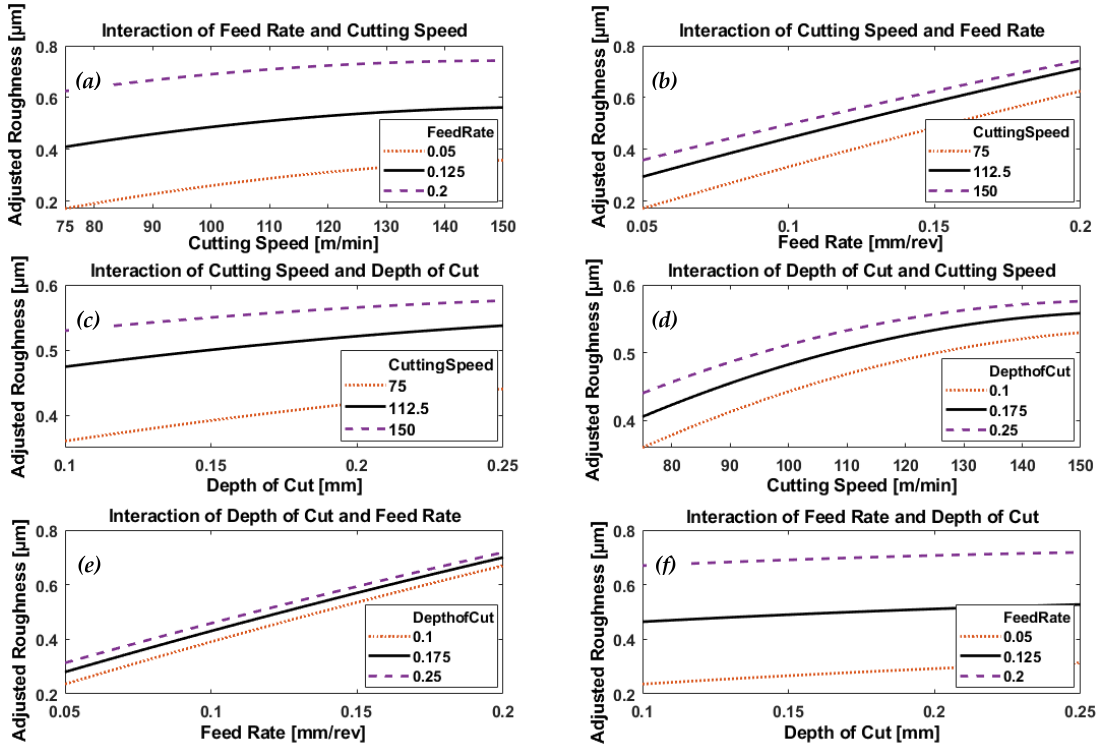
Figure 9. Plots depicting the interactive effects of feed rate, cutting speed, and depth of cut on generated surface roughness of AISI 4340 specimens machined by wiper inserts; ( a ) the effect of cutting speed at different levels of feed rates, ( b ) the effect of feed rate under different levels of cutting speeds, ( c ) the effect of depth of cut at different levels of cutting speeds, ( d ) the effect of cutting speed under different levels of depth of cuts, ( e ) the effect of feed arte at different levels of depth of cuts and ( f ) the effect of depth of cut under different feed rates.